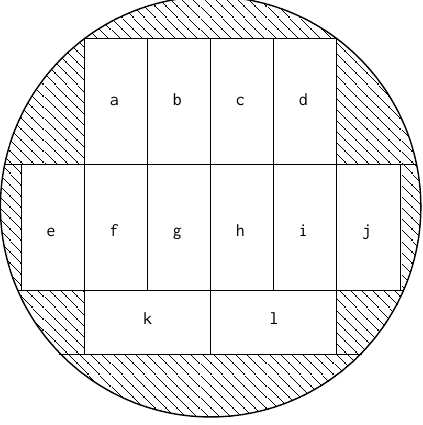
Figure 6. Representative microstructure of the B 34 ice core show- Figure 3. Representative microstructure of the B34 ice core show- ing air bubbles (black inclusions), grain boundaries (black lines) ing air bubbles (black inclusions), grain boundaries (black lines) and the examplary white line, where the grain size was measured. and the white line indicating where the grain size was